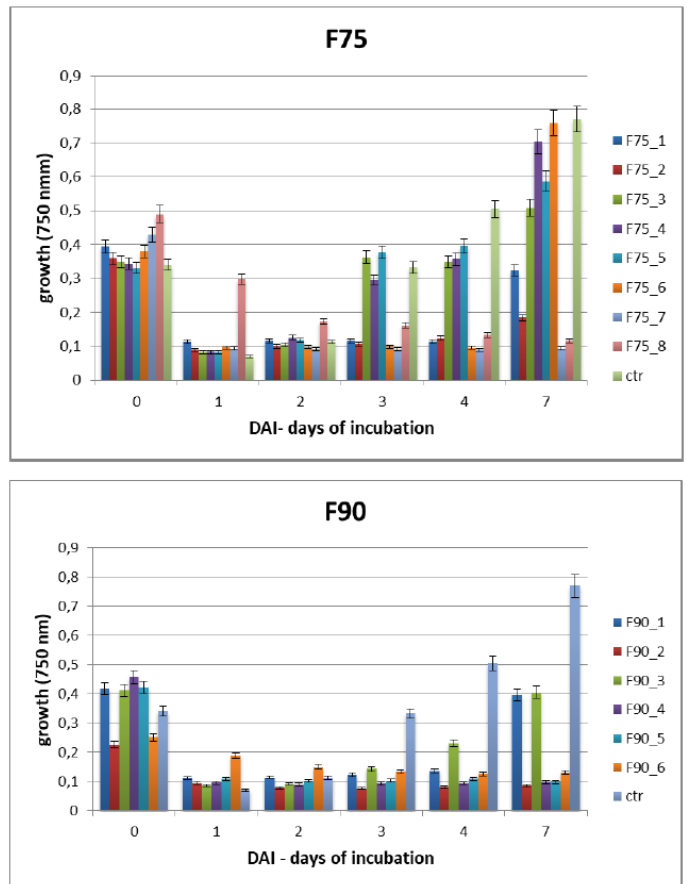
Figure 4. F. langsethiae growth analyzed by Biolog FF microplate analysis at 1, 2, 3, 4 and 7 dai at 25 ◦ C. Untreated control (ctr) and samples treated with F75 1-8 ( A ) and F90 1-6 ( B ). The results are the mean ± SD of 3 different experiments.